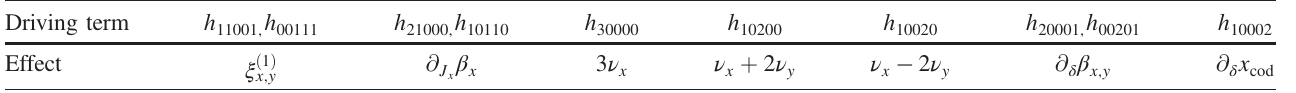
TABLE I. Effects on the dynamics due to the first order sextupolar driving terms. Driving